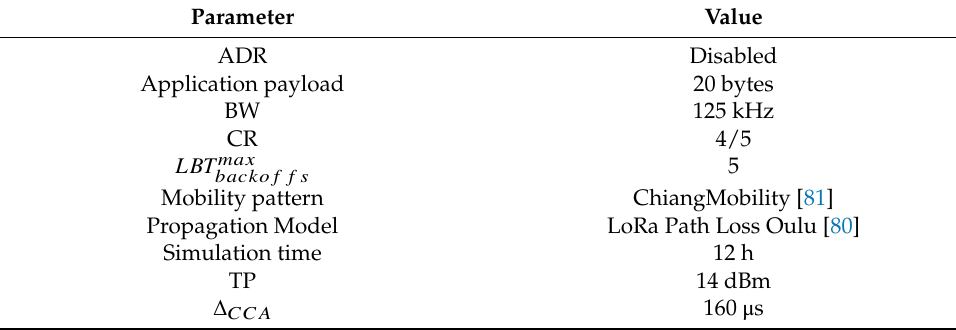
Table 7. Simulation